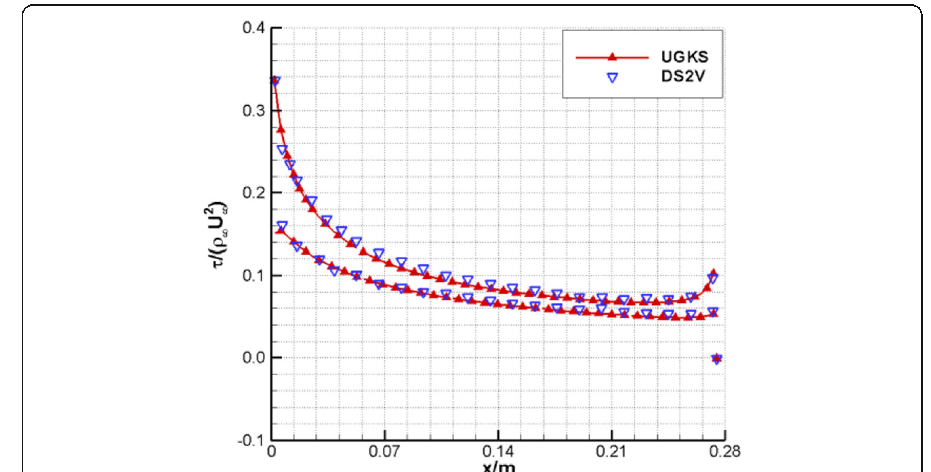
Fig. 7 Shear stress distribution on the wedge surface